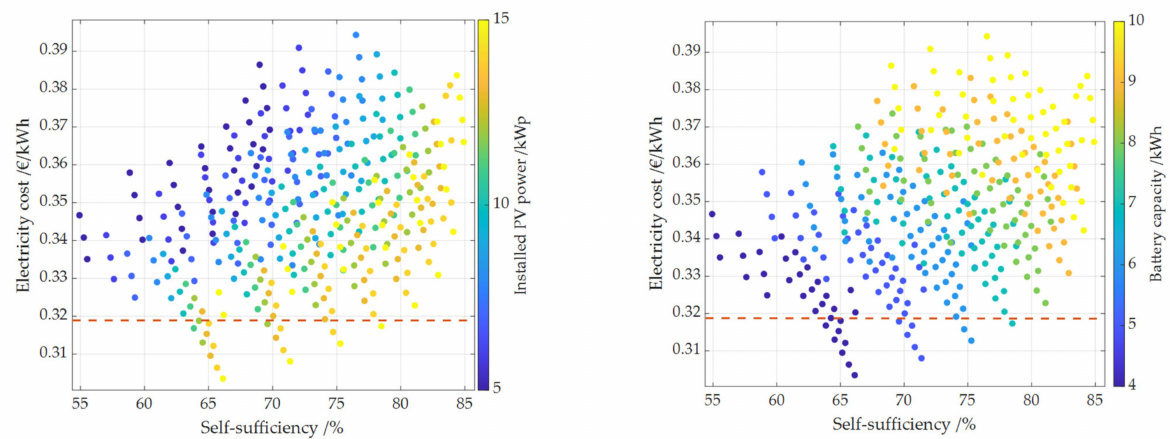
Figure 12. Electricity costs as a function of self-sufficiency. The size of the PV system is shown in color in the left panel and the capacity of the battery is shown in color in the right panel. The simulation is based on an annual electricity price increase of 0%.